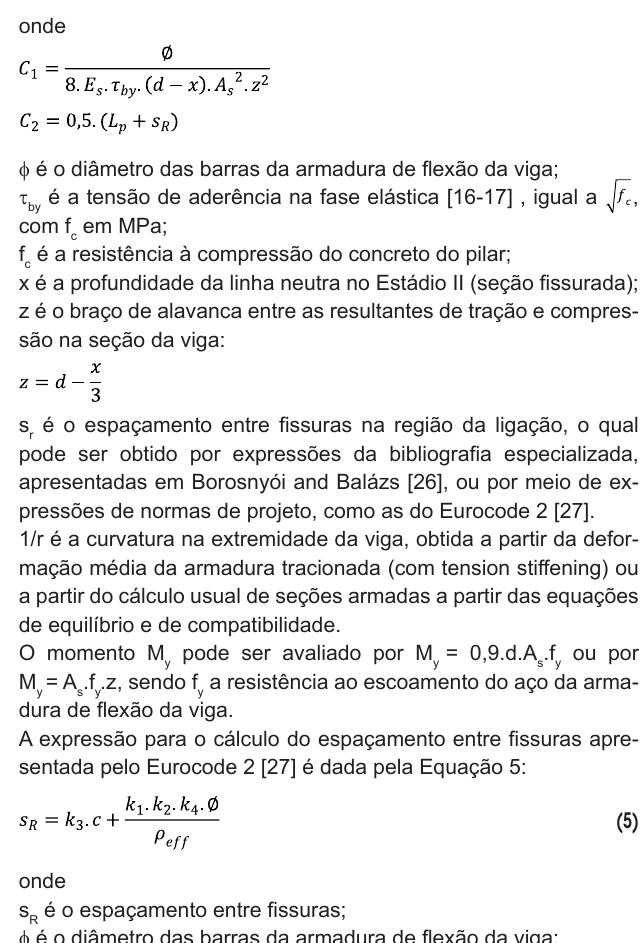
Definição da área efetiva A do espaçamento entre